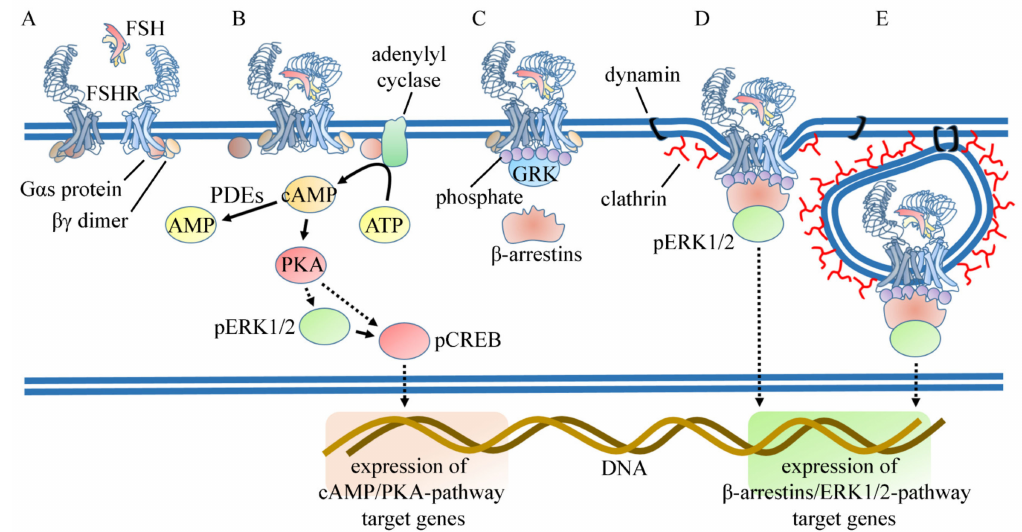
Figure 2. Early FSH-dependent signaling and receptor internalization. ( A ) FSHR extracellular domain is exposed to FSH binding in the cell membrane. ( B ) FSHRs may form multimers in the cell surface and, upon FSH binding, undergo conformational changes inducing activation of the G α s protein and subsequent ATP to cAMP conversion by the adenylyl cyclase enzyme. The downstream PKA, pERK1 / 2, and pCREB activation target CRE sequences, triggering gene expression. ( C ) The GRK enzyme is recruited via a mechanism involving the βγ dimer of the G protein and mediates FSHR phosphorylation at specific intracellular sites. ( D ) β -arrestins form a signaling module associated with FSHR and ERK1 / 2, mediating the assembly of clathrin-coated pits and internalization of the receptor. Besides this β -arrestin / clathrin-related mechanism, the GTPase dynamin may participate in the internalization of FSHR. ( E ) FSH complexed with the receptor is internalized and routed to endosomal compartments sustaining the prolonged activation of signaling